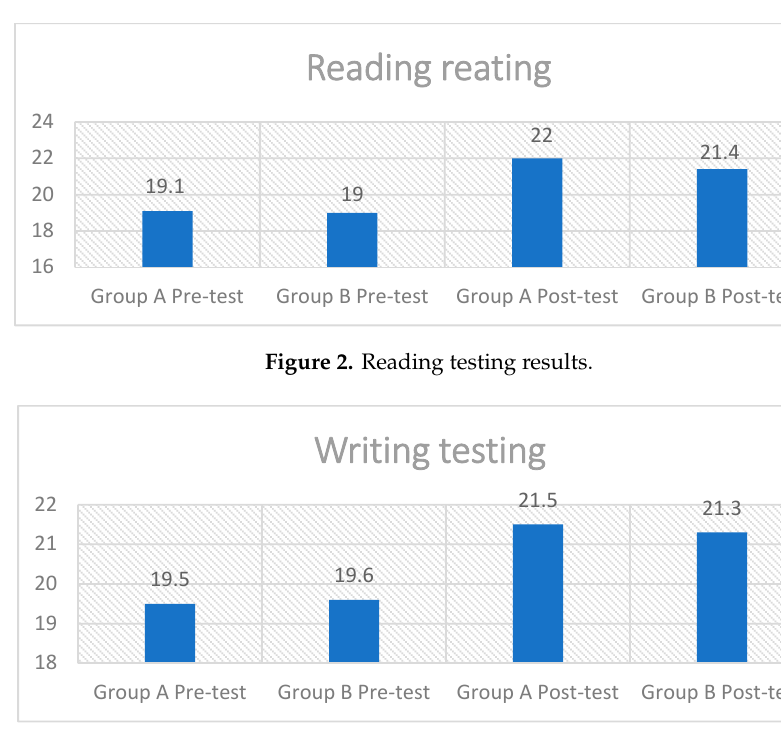
Figure 3. Writing testing results.